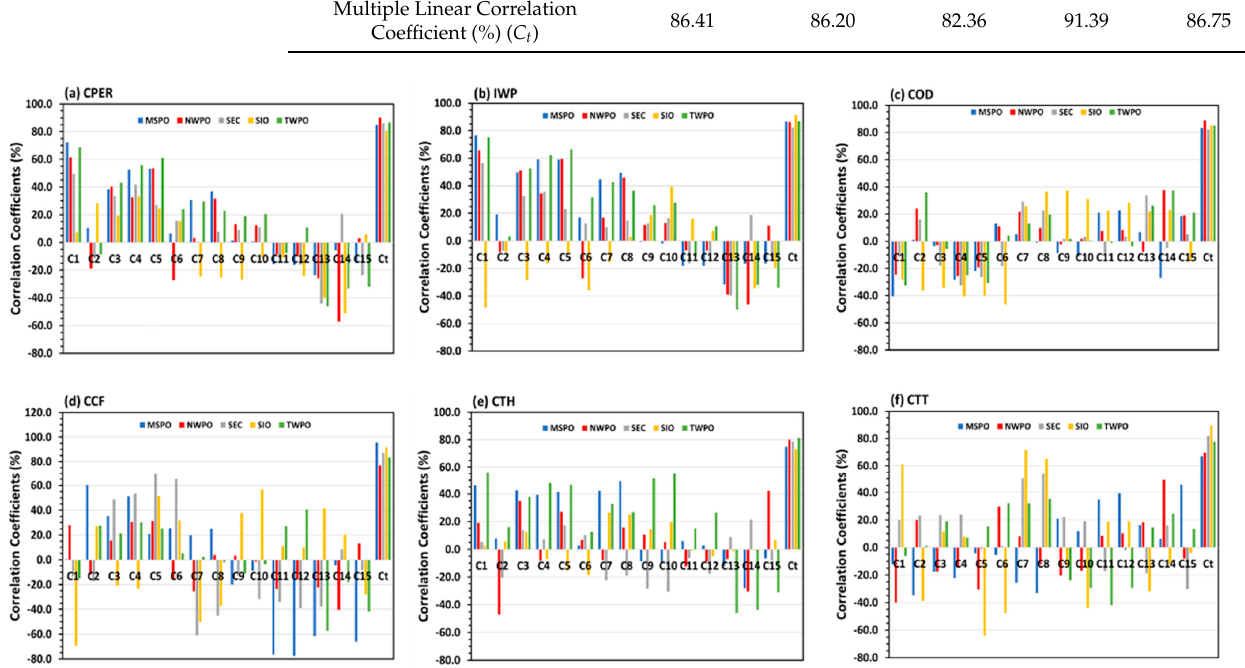
Figure 7. Fifteen normalized individual correlation coefficients (C 1 (AIX), C 2 (CAPE), C 3 (PW), C 4 (RH clm ), C 5 (RH 850 ), C 6 (RH 2m ), C 7 (T 850 ), C 8 (T 2m ), C 9 (U 850 ), C 10 (U 10m ), C 11 (V 850 ), C 12 (V 10m ), C 13 ( ω 850 ), C 14 ( ω sig995 ), C 15 (VSHW)) and the total correlation coefficient (Ct) from the MVLR analysis for the six cloud variables ( a ) CPER, ( b ) IWP, ( c ) COD, ( d ) CCF, ( e ) CTH, and ( f ) CTT in the five regions (MSPO, NWPO, SEC, SIO, and TWPO) of Table